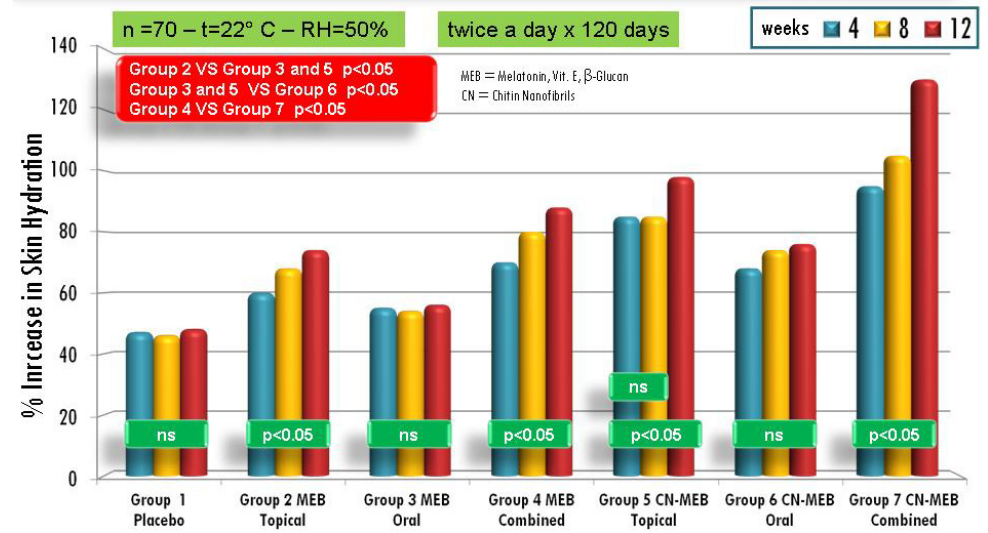
Figure 11. Skin hydration of photo-aged healthy subjects treated topically and/or orally by antioxidant compounds with chitin nanofibrils (% increase vs. baseline values). All p values are highly significant ( p < 0.005) as baseline, placebo and significant ( p < 0.05) as to groups.